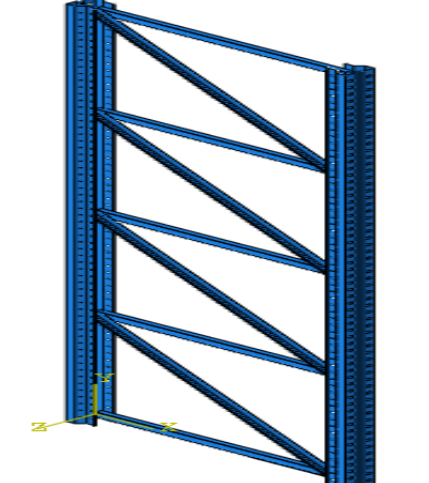
Fig. 5. Typical B2 type frame with inclined and horizontal bracing only